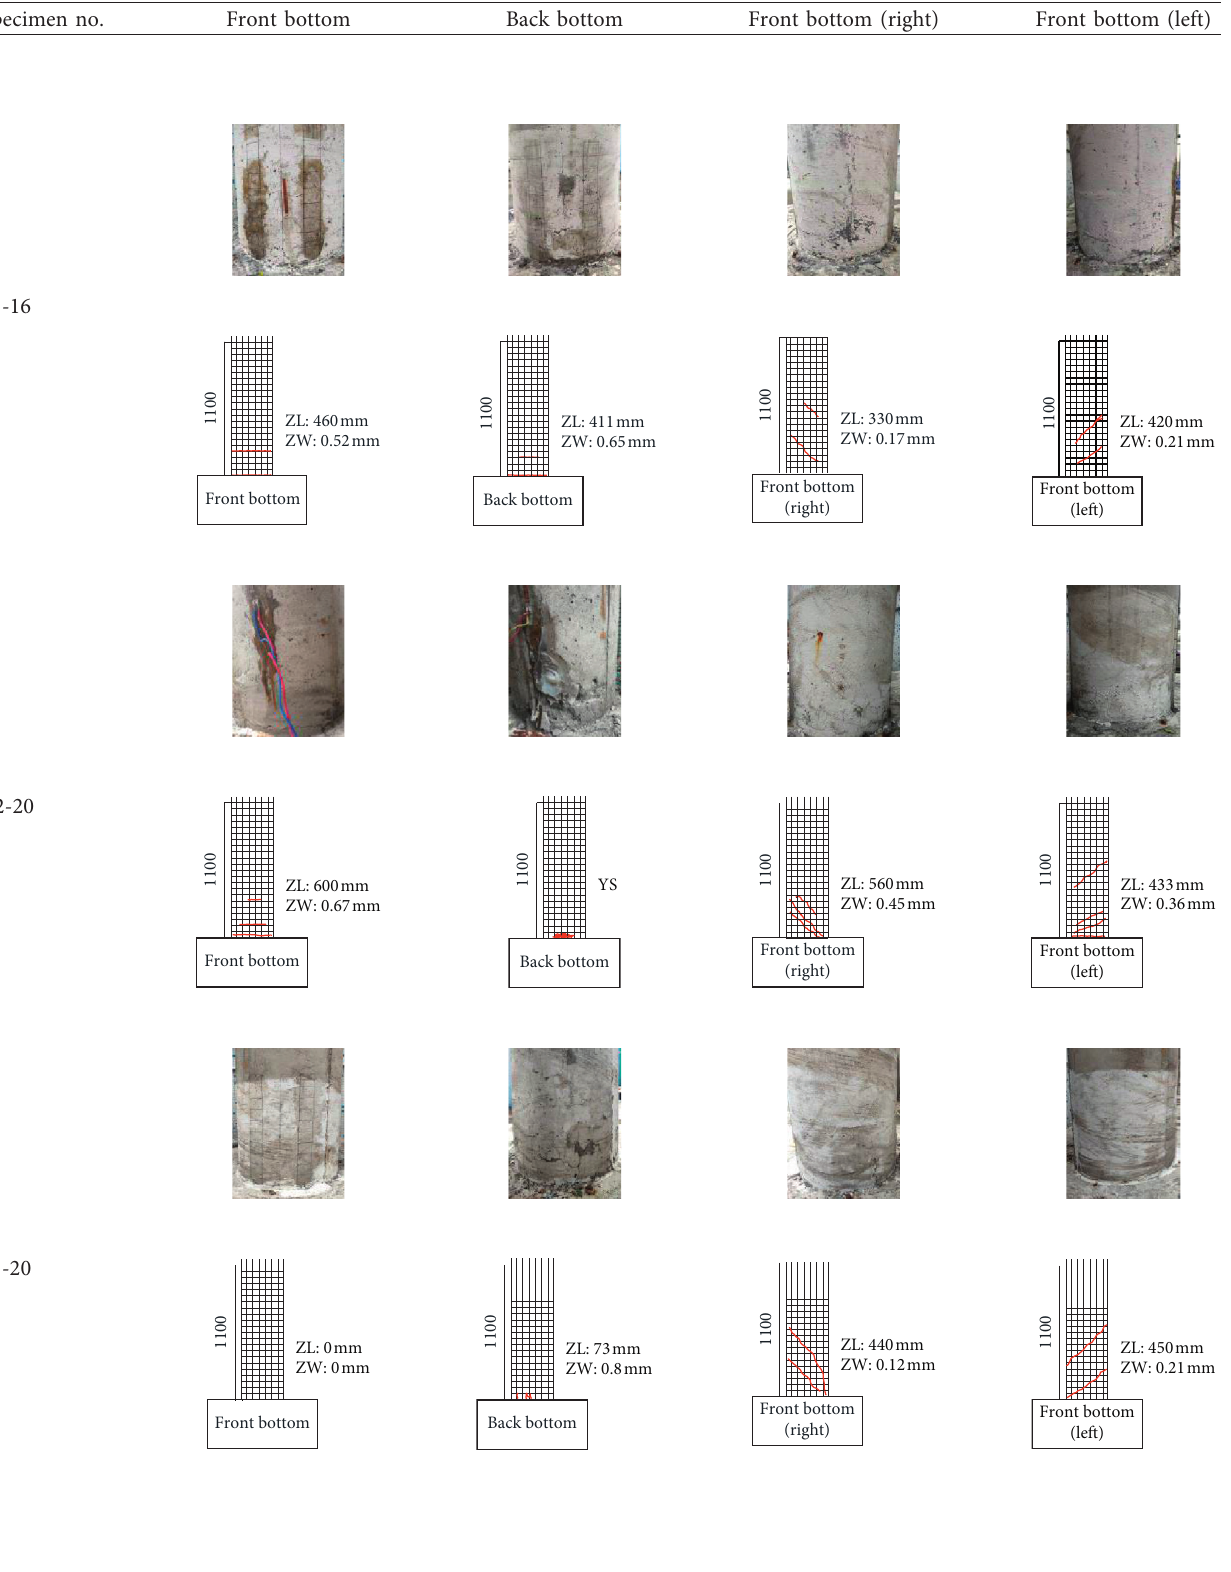
Table 11: Development and failure of the final crack of each specimen. Specimen